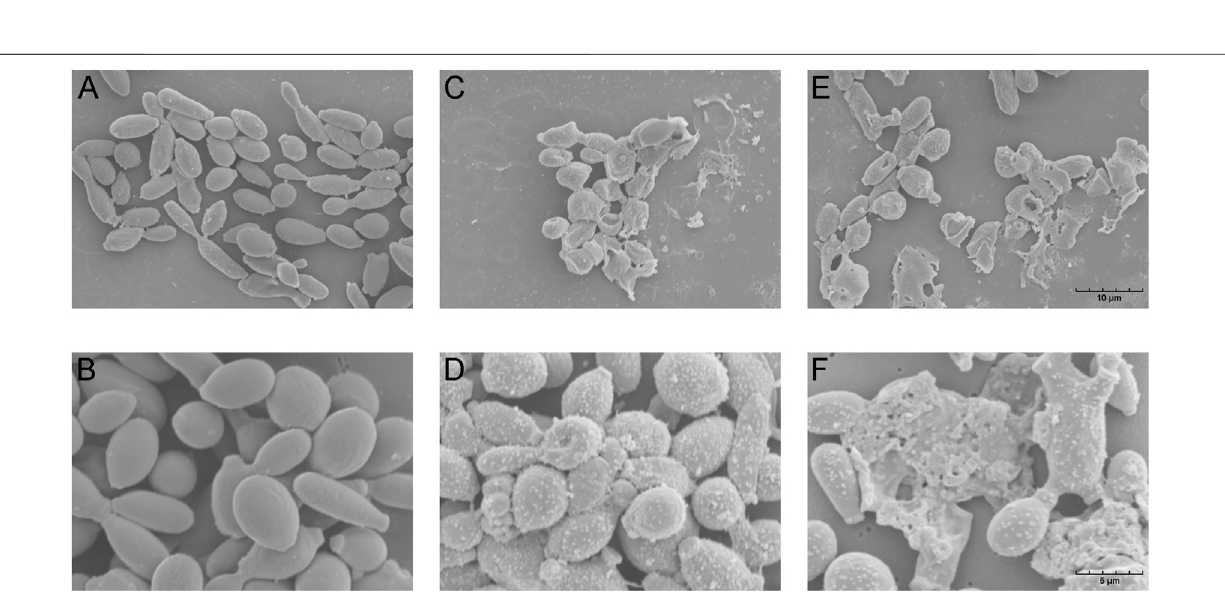
FIGURE 3 | Effect of ToAP2D treatment on morphological changes of S. globosa was observed by SEM (A,B) S. globosa in the control group was normal morphology. (C – F) S. globosa morphological changes after ToAP2D treatment. The scale bars in (A) , (C) , and (E) represent 10 μ m, and those in (B) , (D) , and (F) represent 5 μ